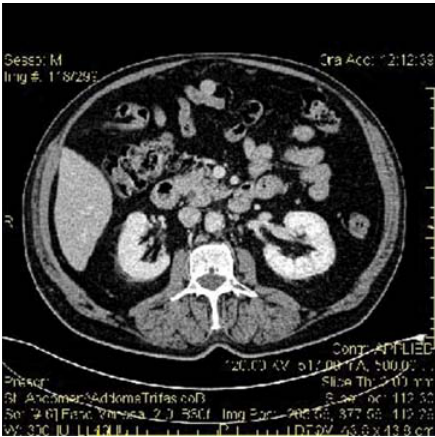
Figure 6: Follow-up CT venous